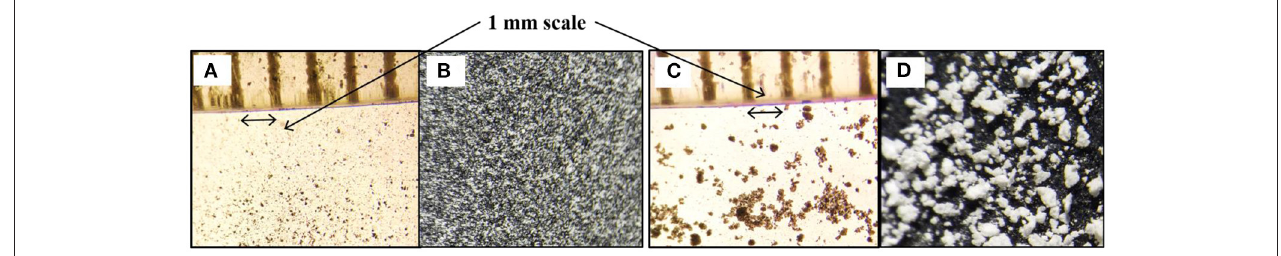
FIGURE 10 | Stereo zoom microscopy at 4X of (A, B) dust from alumina machining and (C, D) green dust partially sintered in transmittance and reflectance modes.